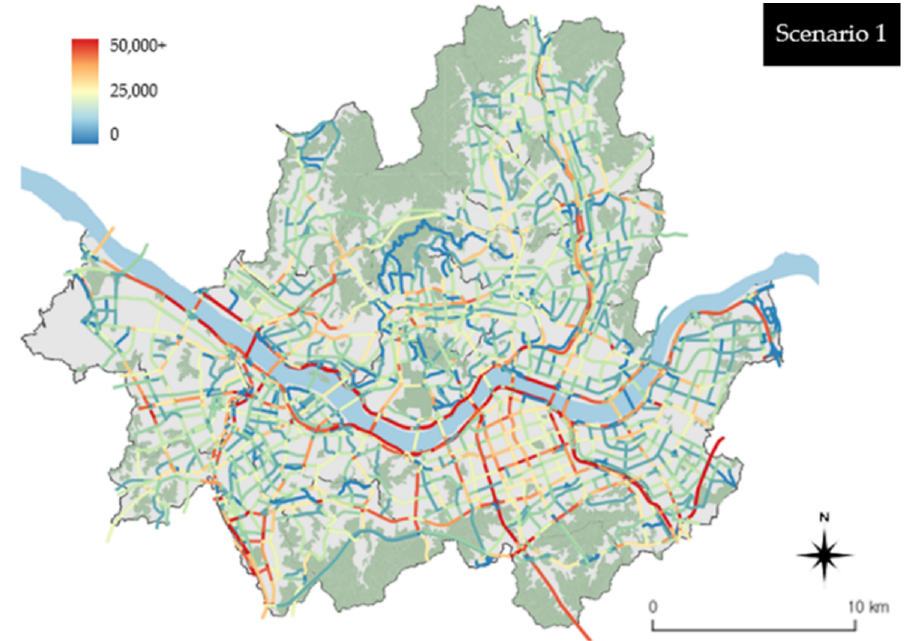
Figure 7. Scenario 1 vehicle emissions by the link units. Figure 8 shows emissions classified based on the link units in the cases of scenarios 2-1 and 2-2, which are based on the results of scenario 1. A comparison between Figures 7 and 8 shows that emissions decreased throughout the city in the cases of scenarios 2-1 and 2-2 compared with scenario 1. A closer look at scenario 2-1 shows that the overall arterial road emissions did not decrease especially compared with those pertaining to scenario 1, but local street emissions in Jongno-gu, Yeongdeungpo-gu, Seocho-gu, and Gangnam-gu decreased. In the case of scenario 2-2, there are areas where emissions decreased in arterial roads and local streets. Among the arterial roads, Gangbyeonbuk-ro and Olympic-daero, which are located along the Hangang River, exhibited reductions in emissions. Across the city, the emissions associated with high-emission arterial roads were reduced. As in scenario 2-1, emissions were reduced in the cases of local streets in Jongno-gu, Yeongdeungpo-gu, Seocho-gu, and Gangnam-gu. In addition, there were areas where emissions were reduced across the city, including Songpa-gu, Seongdong-gu, and Yangcheon-gu. These results indicate that replacing grade 5 vehicles first (associated with the highest emissions) is more effective for reducing emissions throughout the city than replacing grade 4 and 5 vehicles together with eco-friendly vehicles in the case of scenario 2 (Figure